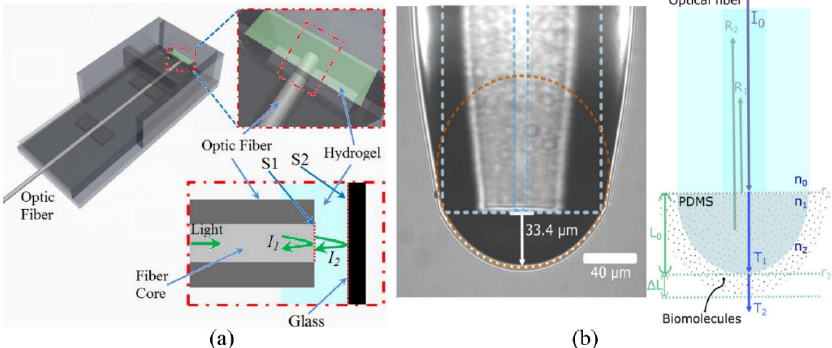
Figure 11. ( a ) Schematic of optical fiber FPI-based sensor using hydrogel. Reproduced from ref. [71] with permission from IEEE. ( b ) Schematic of optical fiber FPI-based sensor using PDMS. Reproduced from ref. [72] with permission © The Optical Society of